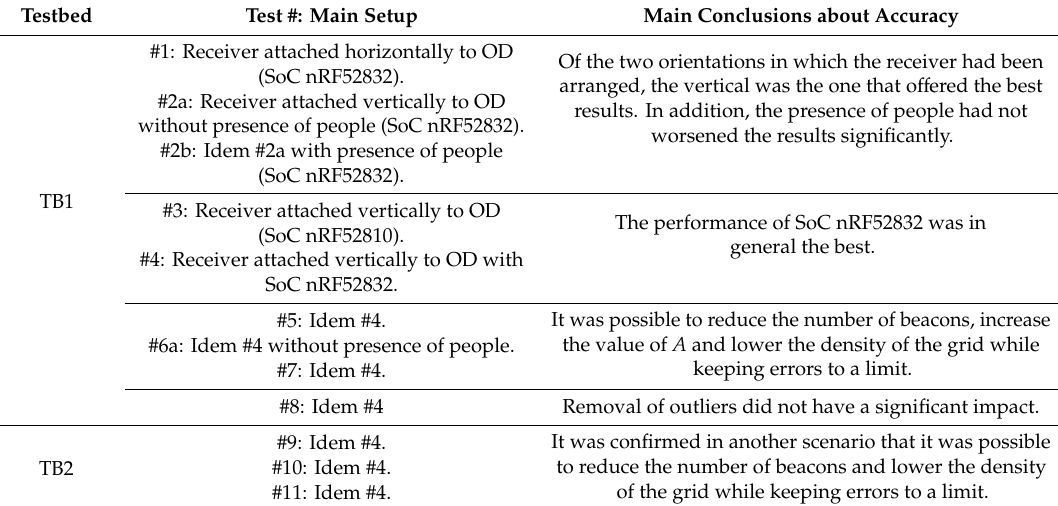
Table 30. Main conclusions about positioning accuracy for the di ff erent